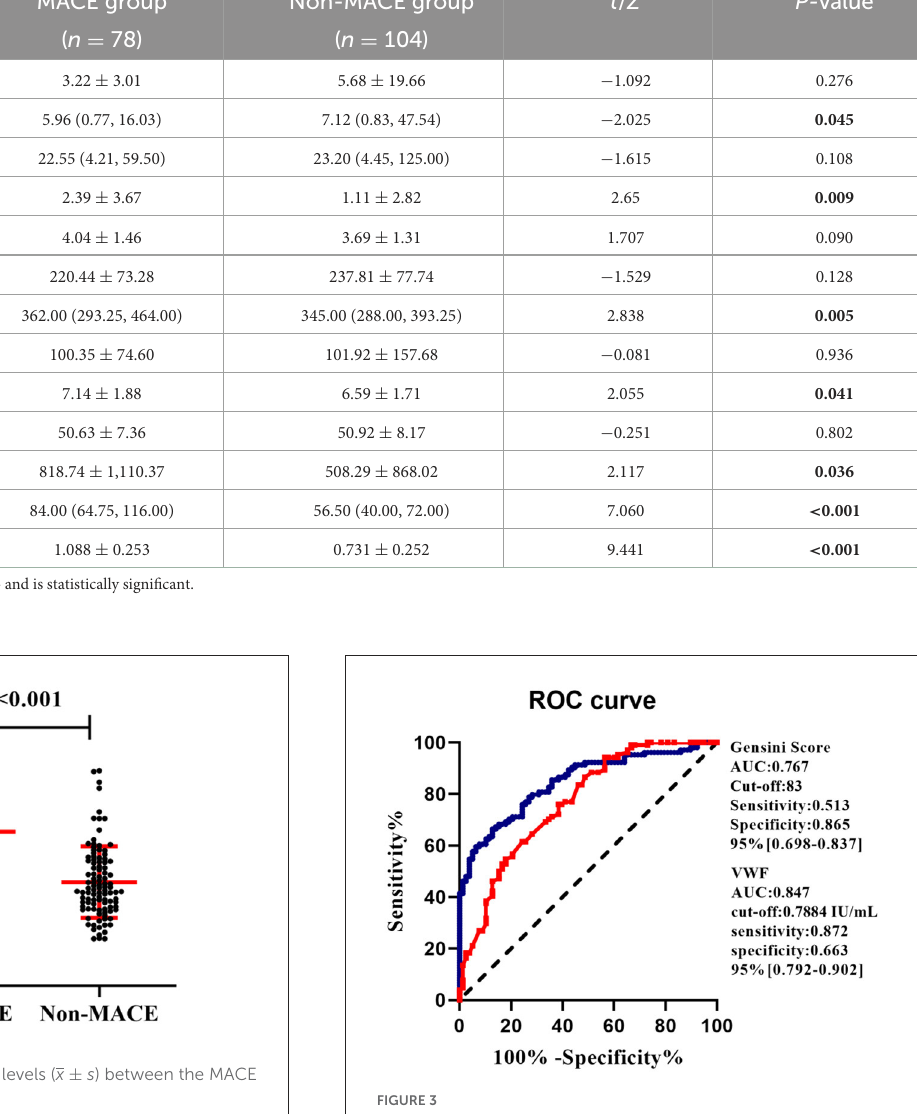
TABLE 3 Comparison of laboratory parameters between the MACE group and the non-MACE group. Variable